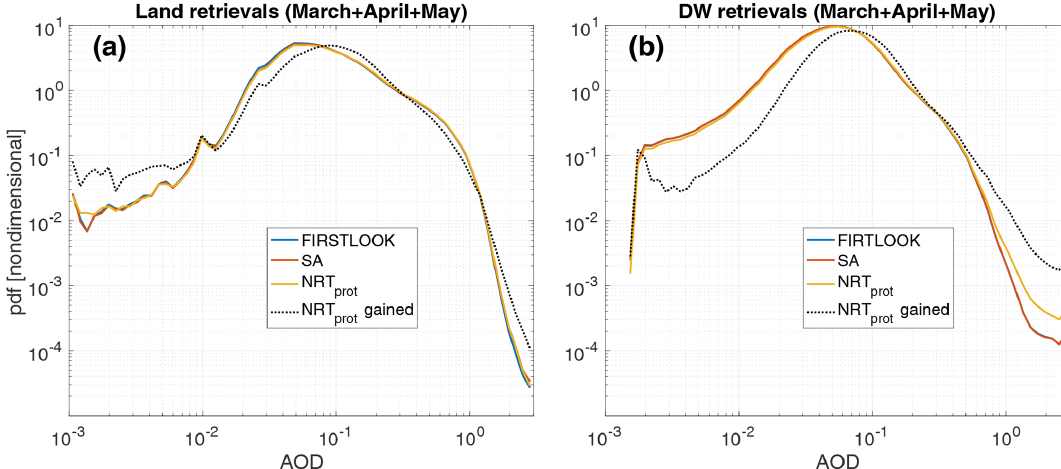
Figure 3. AOD pdf s for land (a) and DW (b) retrievals. Data statistics are provided in Table